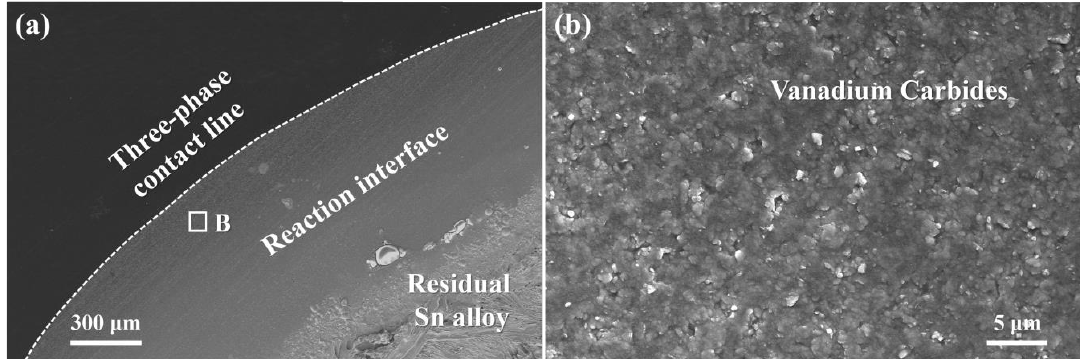
Figure 4. ( a ) Near three-phase contact line morphology between Sn-3V alloy and porous graphite after wetting at 950 °C; ( b ) surface morphology manifested from the location marked by rectangle B in ( a ) after the remained Sn-3V alloy was partly etched by HCl solution.